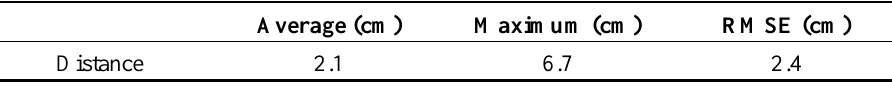
Table 4. Evaluation of the fitted three-dimensional power